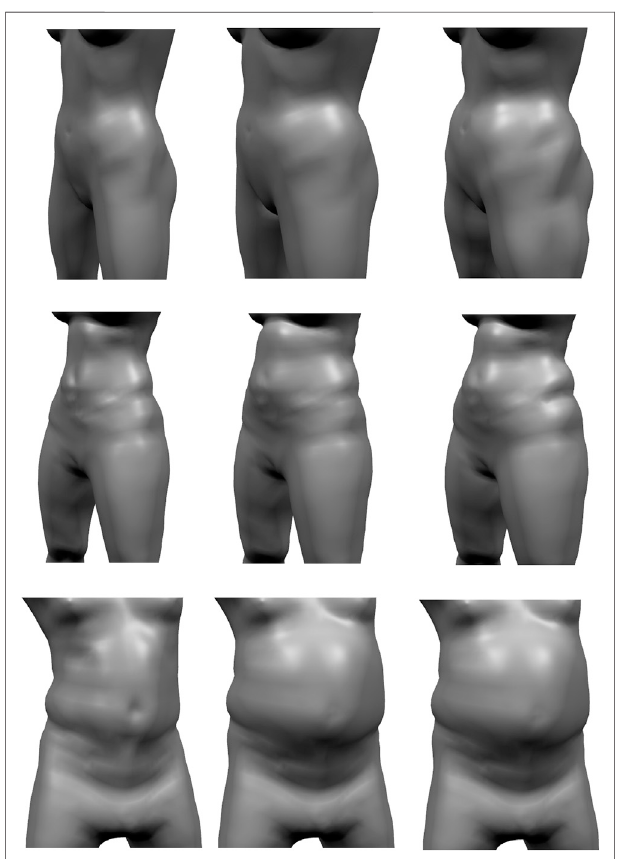
FIGURE13| Givenareconstructedmodel (left) ,thepressure-basedfat growth of Saito et al. (2015) leads to a more uniform increases in fat volume (center) , while our volume-based fat growth increases the initial fat distribution.